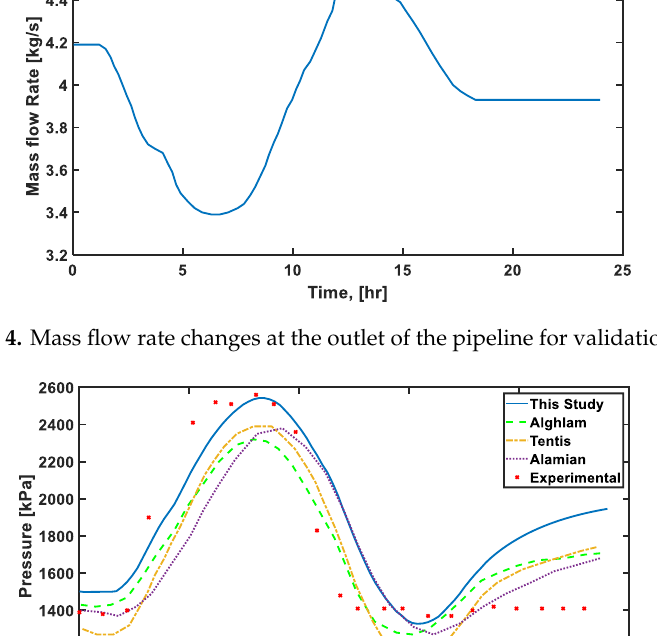
Table 3. Boundary conditions and other parameters used in case study.